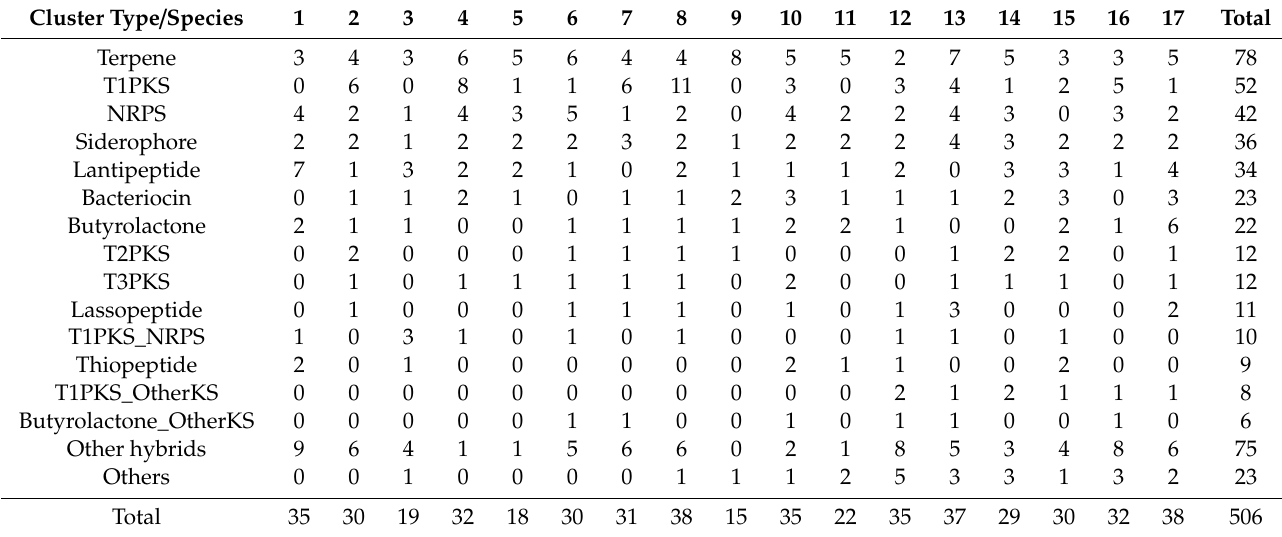
Table 2. Distribution of biosynthetic gene clusters (BGCs) in the genomes of Streptacidiphilus and their comparison with representative Kitasatospora and Streptomyces. Cluster type with an overall aggregate of 10 or above are shown only. Species: 1, S. albus JL83 T ; 2, S. anmyonensis NBRC 103185 T ; 3, S. bronchialis DSM 106435 T ;